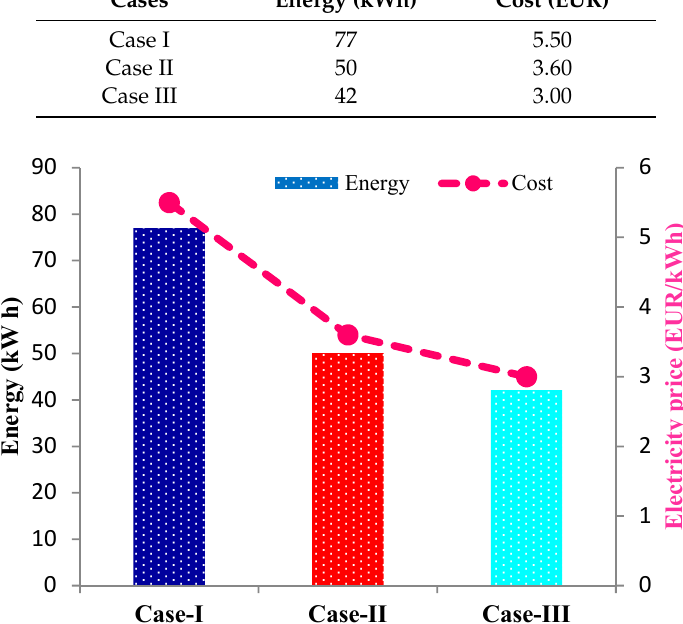
Figure 17. Comparison of average daily energy consumption and cost management within case-I, II, and III.